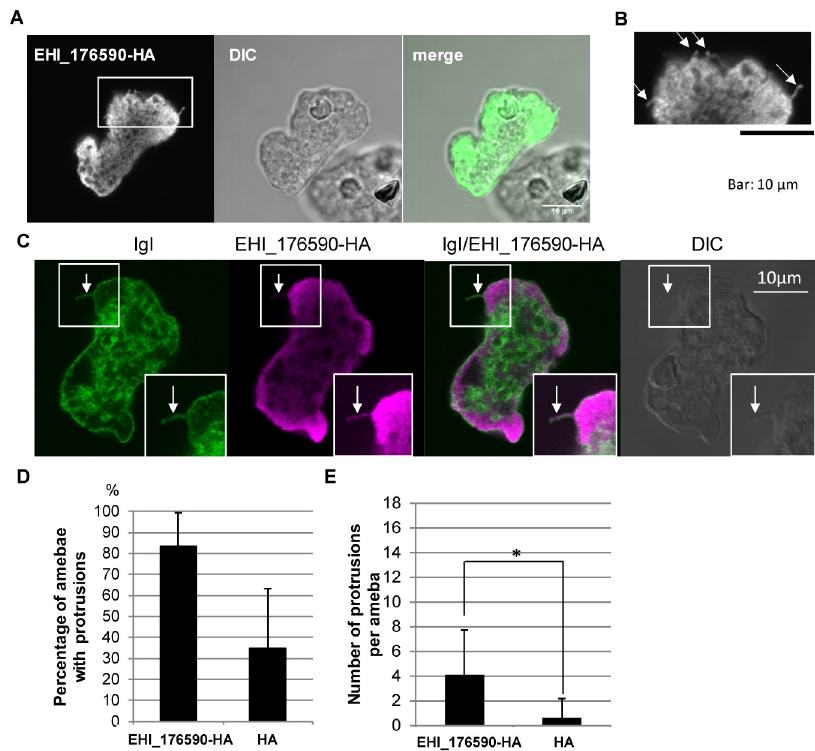
Fig 5. Localization of EHI_175690, and protrusion formation on EHI_175690-HA-expressing amoebae. (A) Immunofluorescence image, obtained by confocal microscopy, showing localization of EHI_176590. EHI_176590-HA- expressing amoebae were fixed and reacted with anti-HA antibody. (B) Magnified image of the inset in (A). Arrows indicate protrusions. (C) Immunofluorescence image, obtained by confocal microscopy, showing localization of EHI_176590-HA and the intermediate subunit of galactose/N-acetylgalactosamine-specific lectin (Igl). EHI_176590-HA-expressing amoebae were fixed and stained with anti-HA and anti-Igl antibodies. Arrow indicates protrusion. Islet showing signal-enhanced image to highlight the protrusion. (D) Effect of EHI_176590-HA expression on the percentage of amoebae that possess protrusions. EHI_176590-HA-expressing and mock transformants (HA) were immunostained as in (C) and the number of cells with protrusions, longer than 0.7 μ m, was counted and are presented as percentages. The averages of three independent experiments, in which 100–200 amoebae were counted, are shown. (E) Effect of EHI_176590-HA expression on the number of protrusions per amoeba. EHI_176590-HA- expressing and mock transformants (HA) were immunostained as in (C), and the number of protrusions, per amoeba, was counted. The averages of three independent experiments, in which 100–200 amoebae were counted, are shown. (cid:3) indicates p <